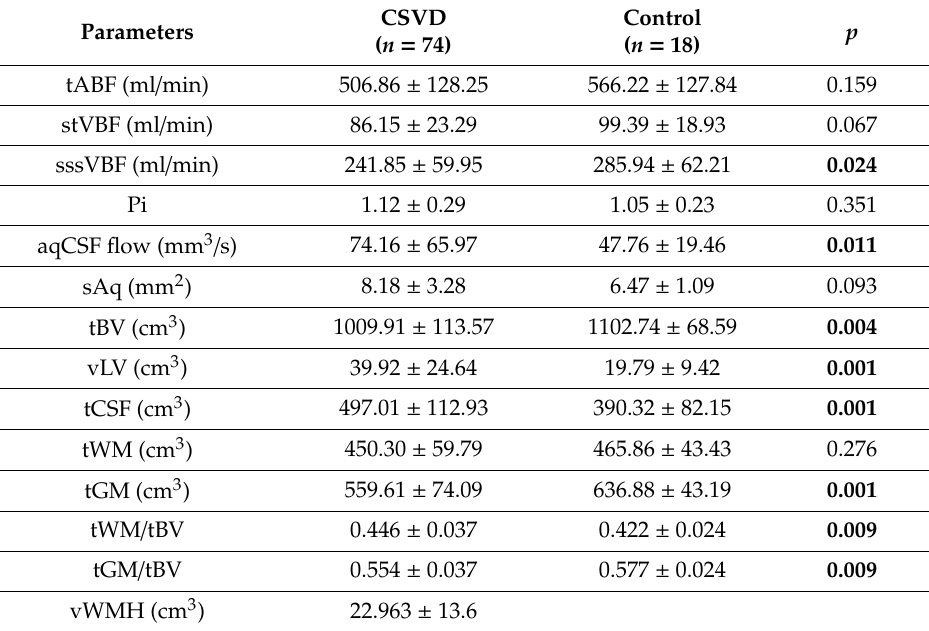
Table 5. MRI results in subjects with CSVD and the